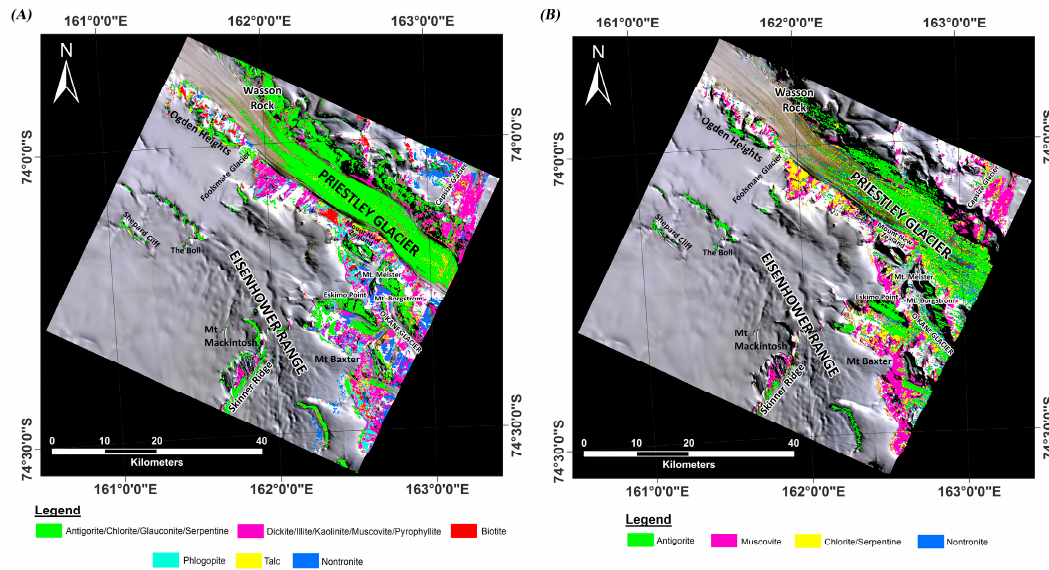
FIG 11 Figure 11. ( A ) CEM classification mineral map for the Priestley Glacier scene derived from fraction images of the selected endmember minerals using ASTER VINR+SWIR bands. ( B ) CEM classification mineral map for the Priestley Glacier scene derived from fraction images of the selected endmember minerals using ASTER TIR bands.